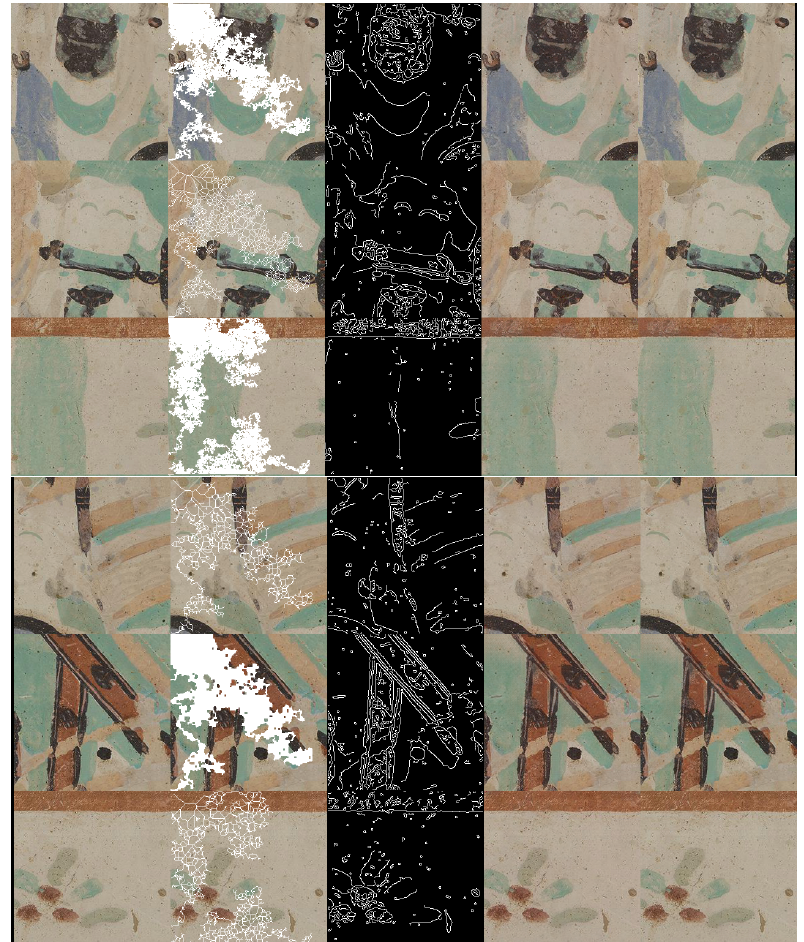
Figure 5. Intermediate results generated for a subset of random six images from the validation set (original size of the images is 256 × 256, scaled to fit in the page). For each of the six instances, five images are shown, in order from left to right: ground-truth; ground-truth with deterioration; edge map in the missing region; output inpainted image with both edge and color information as generated by the network; and, output of the model merged with the non-masked input pixels.